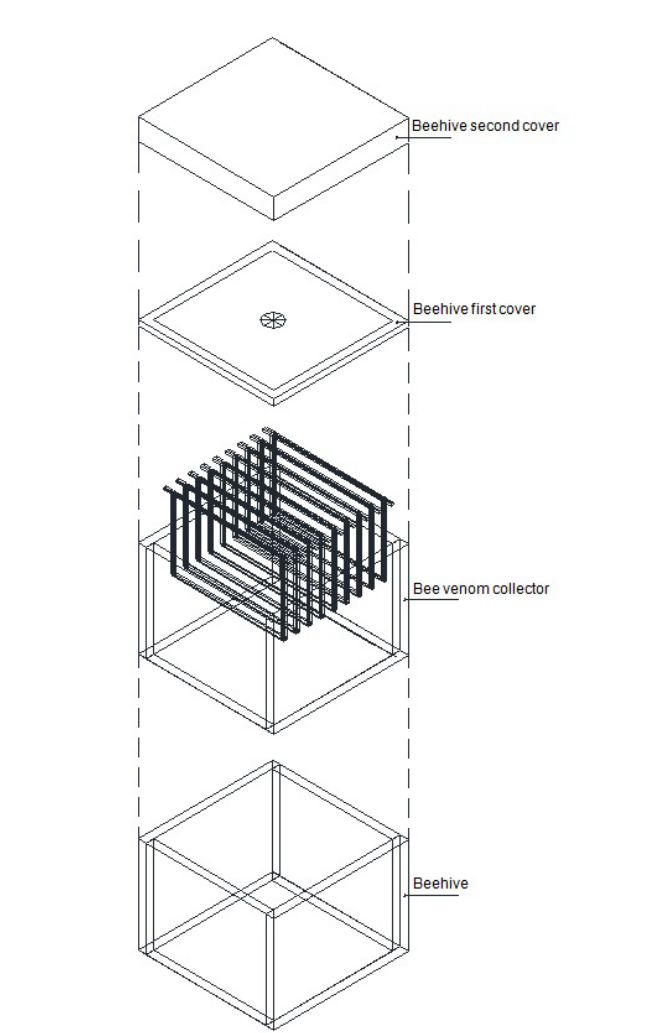
Figure 3. Intensive Collector